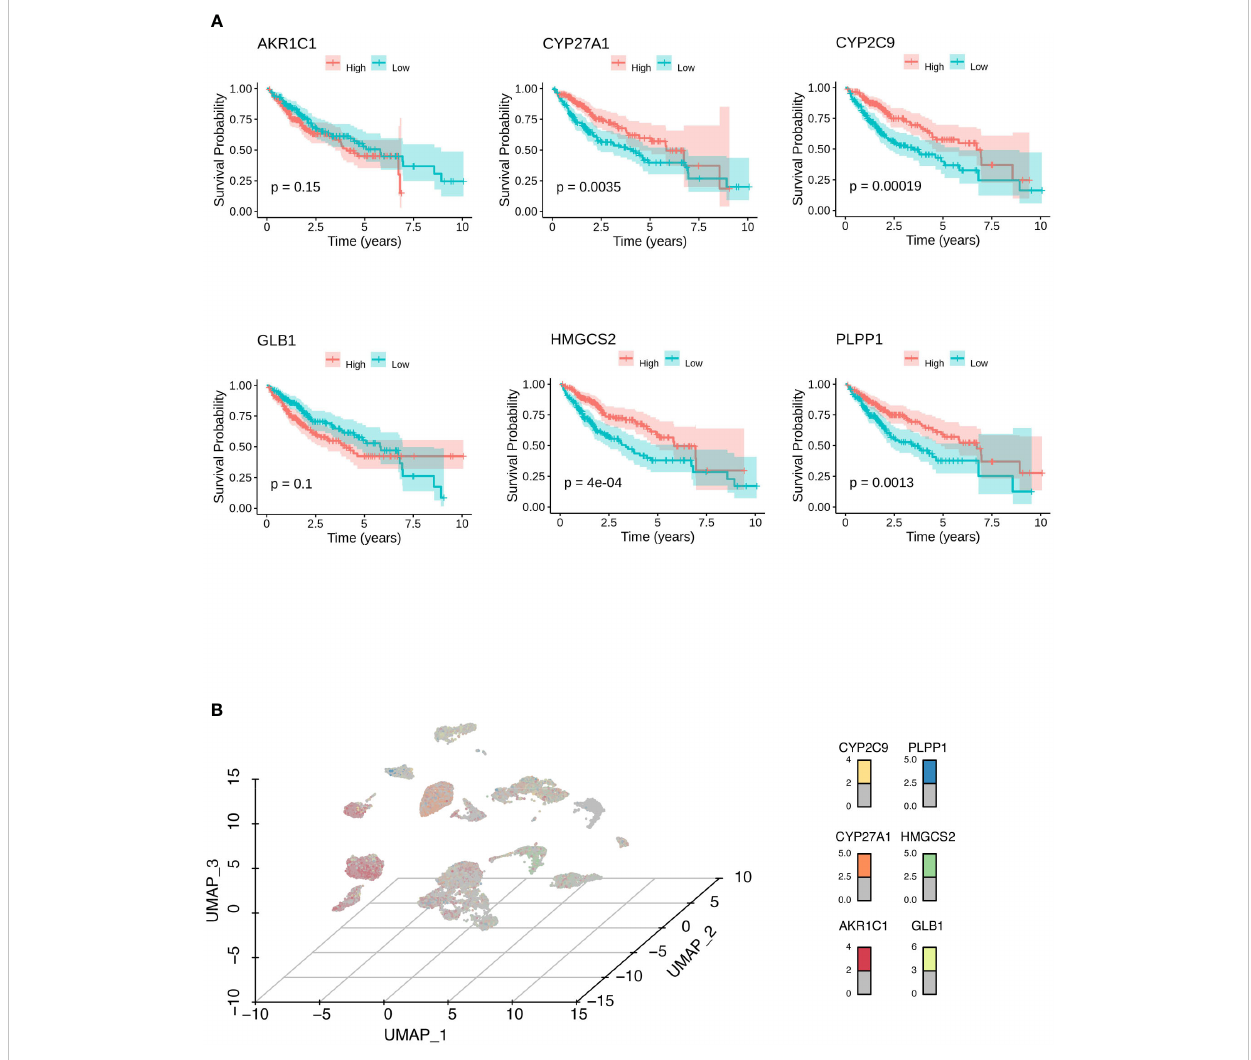
FIGURE 3 Identi fi cation of biomarkers for HCC. (A) Kaplan-Meier analysis showed the survival probabilities of HCC patients with high and low expression of the hub LMRG gene ( AKR1C1 , CYP27A1 , CYP2C9 , GLB1 , HMGCS2 , and PLPP1 ). (B) UMAP results showed the expression of the hub LMRG genes ( AKR1C1 , CYP27A1 , CYP2C9 , GLB1 , HMGCS2 , and PLPP1 ) in single-cell